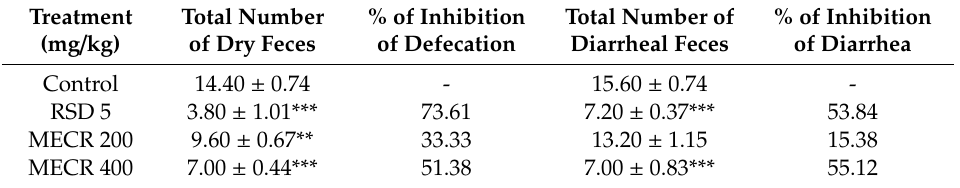
Table 2. The e ff ect of MECR on feces count in castor oil-induced diarrhea in mice. Treatment (mg /